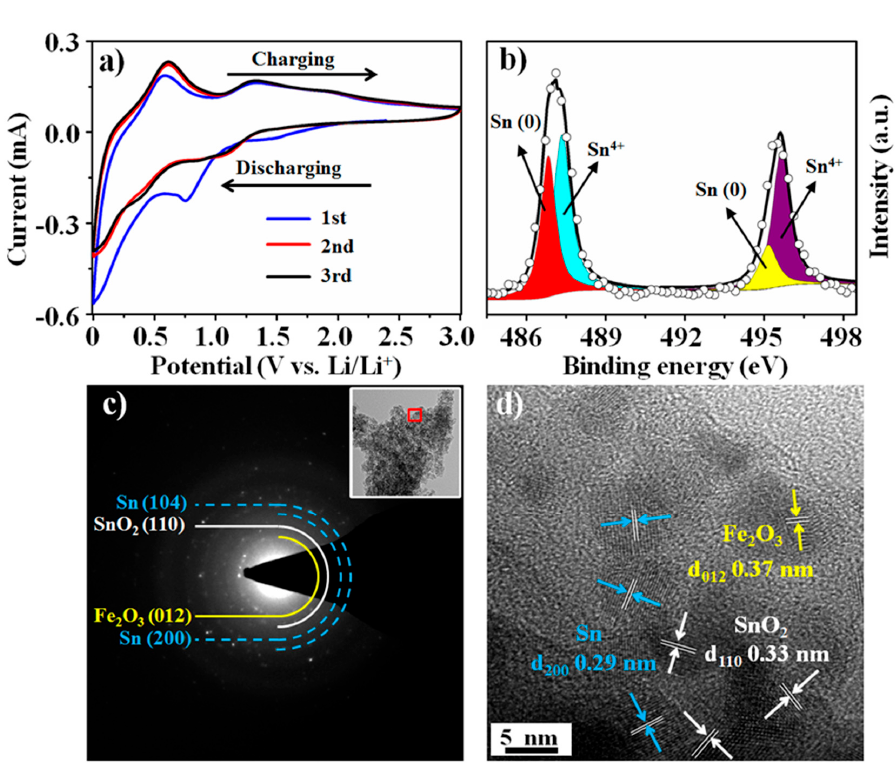
Figure 4. ( a ) cyclic voltammetry (CV) curves of B-SFO@C electrode at a scan rate of 0.1 mV s − 1 , ( b ) The X-ray photoelectron spectroscopy (XPS)spectrum of Sn 3d for B-SFO@C at full-charged state, ( c ) selected area electron diffraction (SAED) pattern of B-SFO@C at full-charged state and corresponding low-resolution TEM image (inset), ( d ) HRTEM image of B-SFO@C at full-charged state.